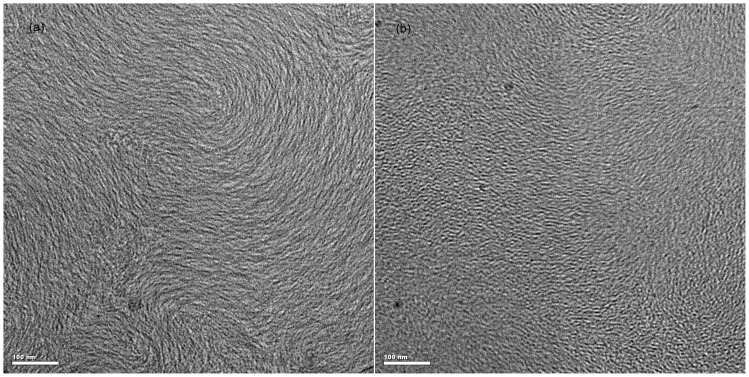
Cryo-TEM images.(a) 70 mM C16MPBr/30 mM SL solution; (b) 70 mM C16MPBr/35 mM SL solution.